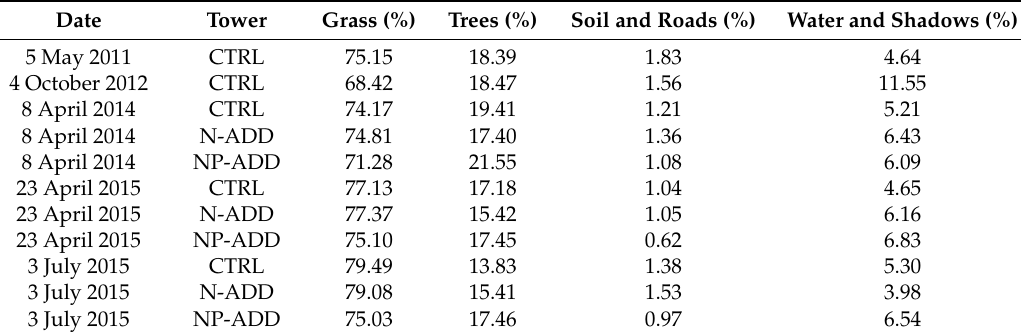
Table 3. Frequency of the different classes in the airborne imagery.